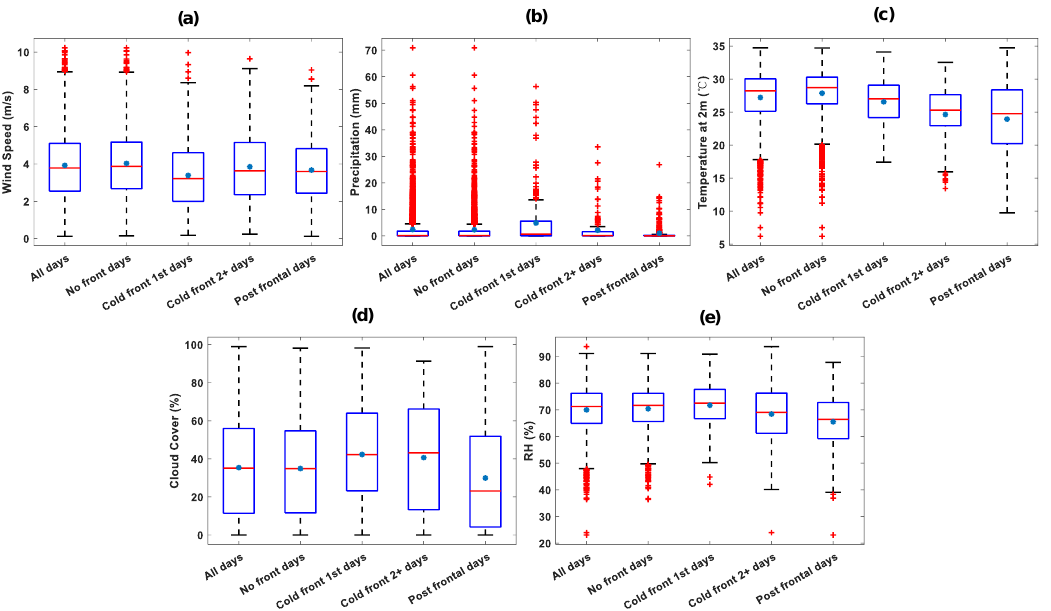
Figure 8. Box plots of ( a ) wind speed; ( b ) precipitation; ( c ) temperature; ( d ) cloud cover; ( e ) RH during each type of days (blue “*” represents the means; red lines are the medians; red “+” marks are the